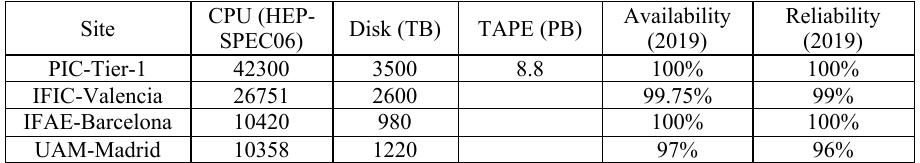
Table 1. Resources and performance of the Spanish cloud facilities for the ATLAS